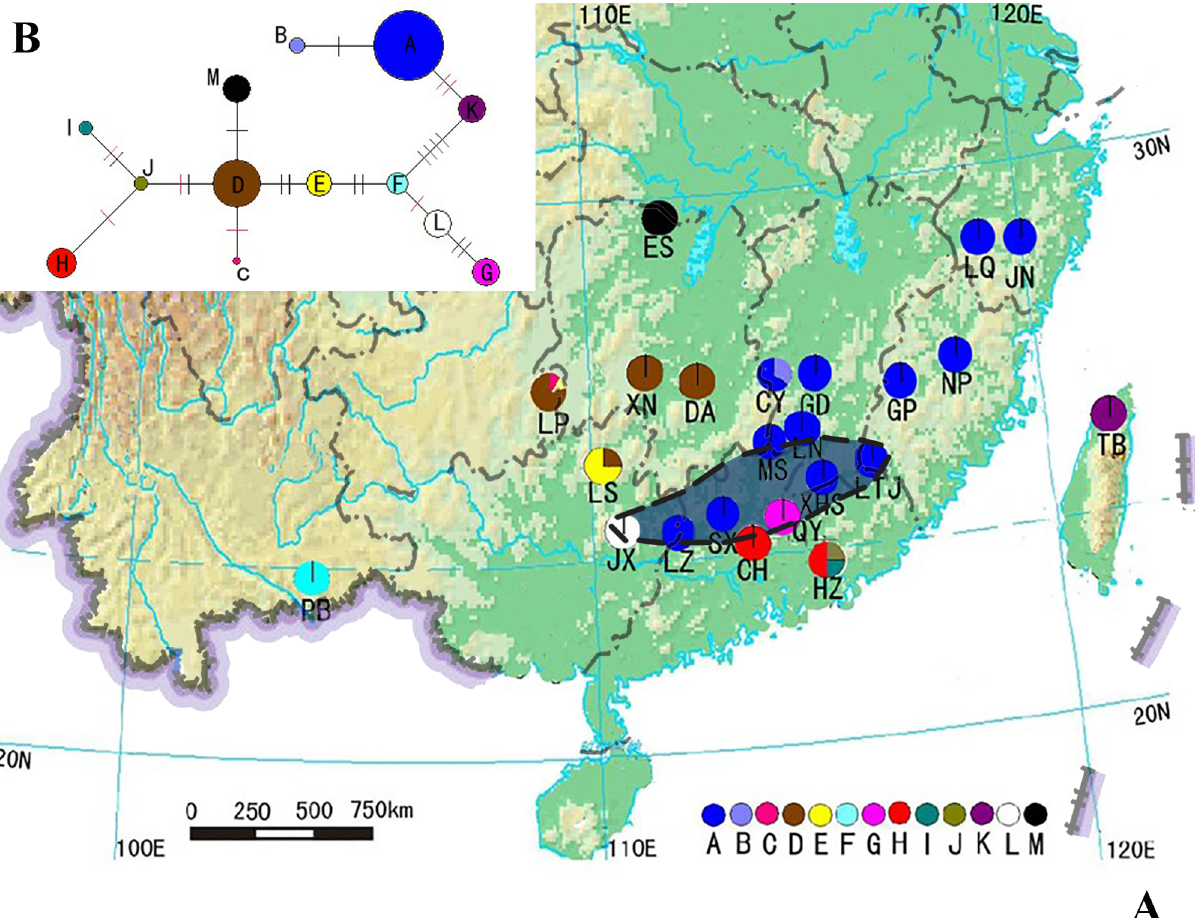
Fig 1. Distribution (A) and network (B) of Bretschneidera sinensis haplotypes. (A) Distributionof 13 Bretschneidera sinensis haplotypesin China. Letters belowthe colorful circles in the map stand for the population names; different colorful circles are to distinguish the haplotypes (see Legend);the shadowarea with dashedmargin indicades the approximate coverageof NanlingMtn. (B) Network of Bretschneidera sinensis haplotypes in China. Median-joiningnetwork of the 13 haplotypes of B . sinensis .Solid bars indicatethe numberof mutation steps, black bars represent parsimony sites, and red bars represent cpSSR variation. The size of circles reflects the frequencyof haplotypesobserved.